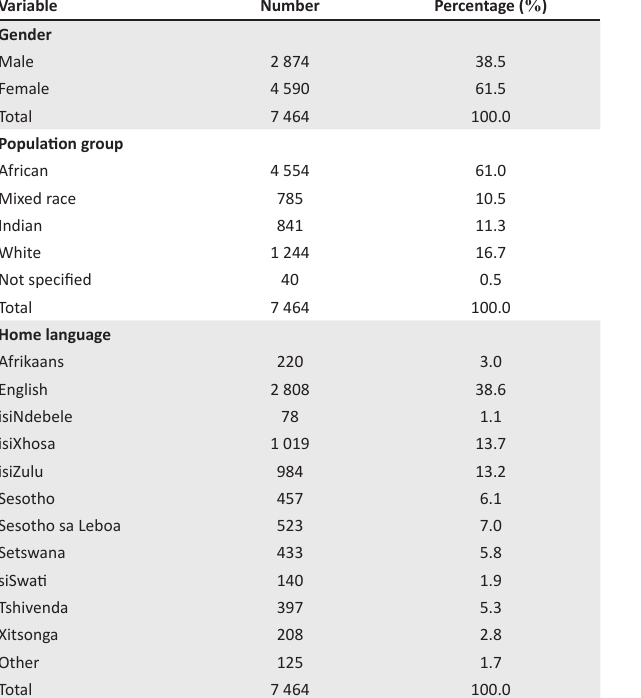
TABLE 5: Demographic characteristics of the total sample of National Benchmark Tests Project quantitative literacy test candidates ( N = 7 464).